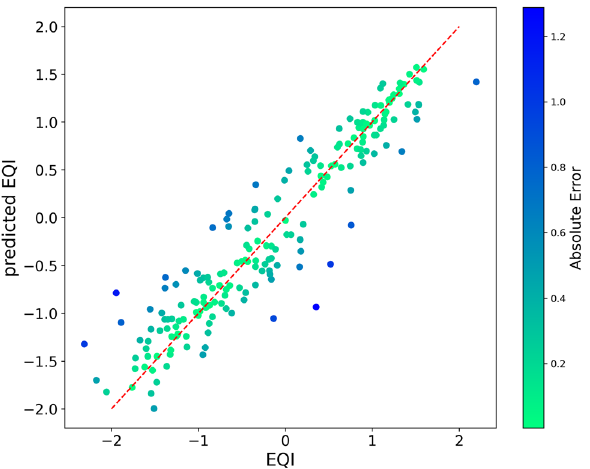
Figure 2. Scatter plot reporting the relation between the true value of EQI 2021 for European Union regions, and the prediction provided by XGBoost regression, operated in the leave-one-out mode. The regression 2 = 0.8877 algorithm performance is quantified by the value r of the coefficient of